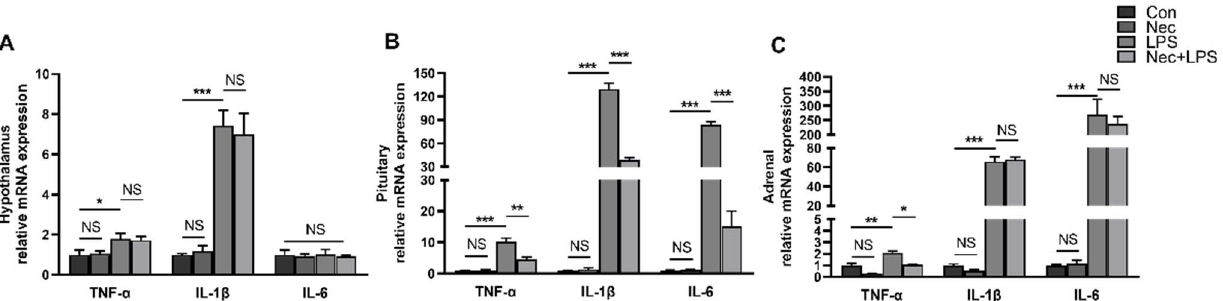
Figure 6. Nec-1 alleviates LPS-induced inflammation of pituitary and adrenal gland: ( A ) mRNA expression of TNF- α , IL-1 β , and IL-6 in the hypothalamus; ( B ) mRNA expression of TNF- α , IL-1 β , and IL-6 in the pituitary gland; and ( C ) mRNA expression of TNF- α , IL-1 β , and IL-6 in the adrenal gland. The pigs were pretreated intraperitoneally with Nec-1 at 1.0 mg/kg BW or equal volume of 2% DMSO solution 30 min before the intraperitoneal injection of LPS or saline, and the pigs were sacrificed at 4 h after LPS or saline injection. Values are means ± SEM, n = 7. NS means no significance, * p < 0.05, ** p < 0.01, and *** p <